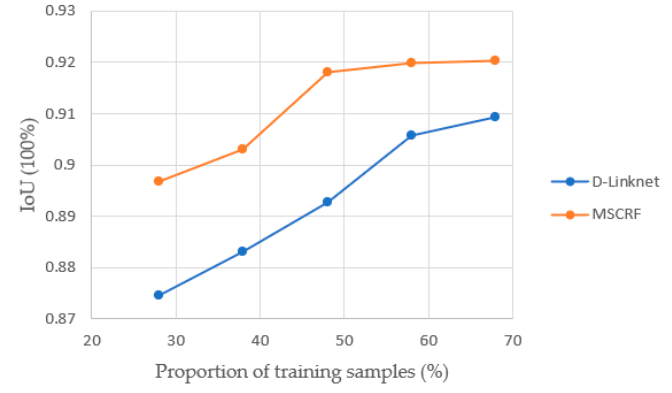
Figure 13. Analytical diagram of building extraction results with different number of Samples. The IoU of D ‐ Linknet and MSCRF with different numbers of training samples using the WHU building dataset.